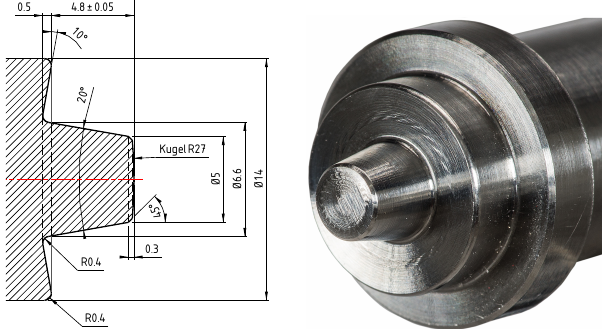
Figure 1. Base geometry: relevant dimensions and manufactured tool made from QRO ® 90.